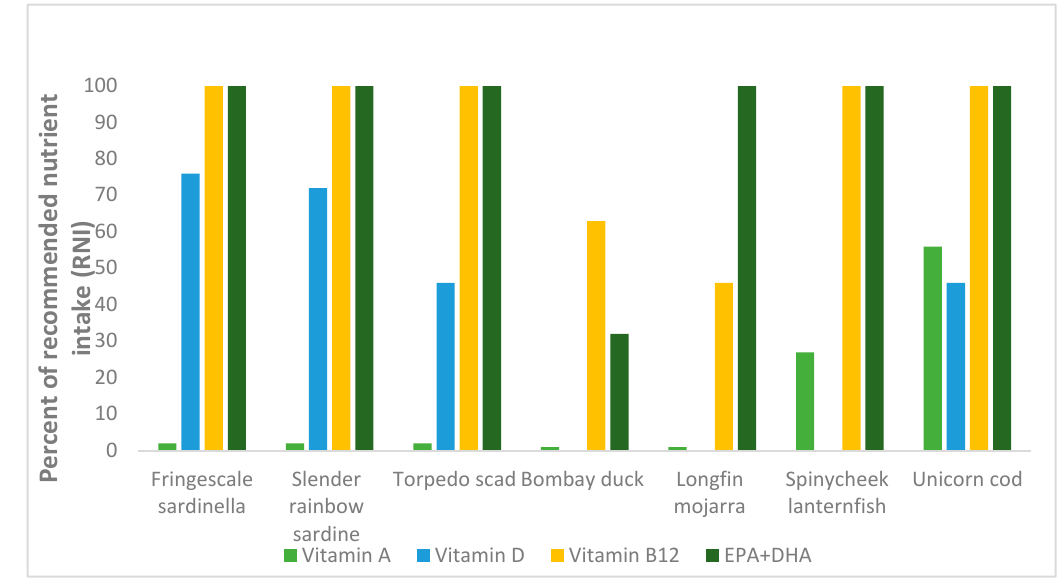
Figure 2. Percentage of recommended nutrient intake (RNI) for women of EPA + DHA and selected vitamins of 100 g raw, edible parts of Fringescale sardinella (fillet), Slender rainbow sardine (fillet), Torpedo scad (fillet), Bombay duck (fillet), Longfin mojarra (fillet), Spinycheek lanternfish (whole fish), and Unicorn cod (whole fish).